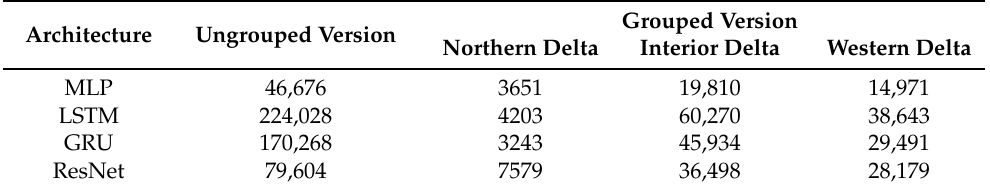
Table A7. Total numbers of parameters of each architecture proposed, including ungrouped version (one model for 28 stations) and grouped version (three models, one for each station group).